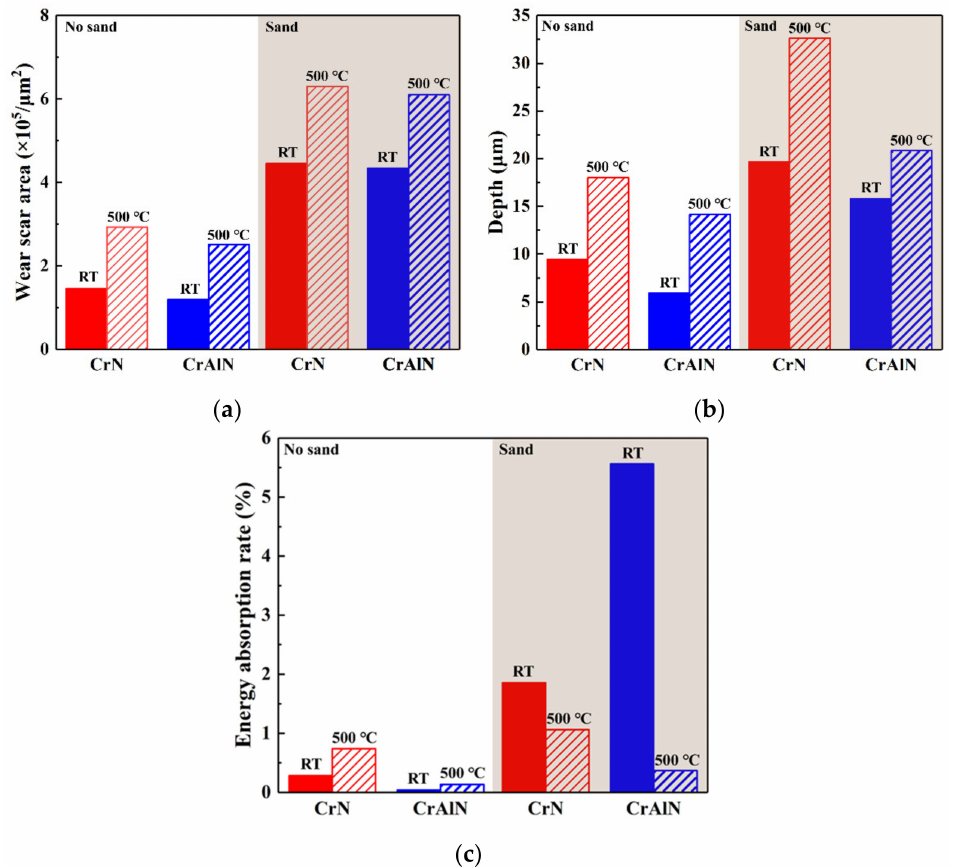
Figure 10. Area and depth of wear scar and total energy absorbed of the CrN and CrAlN coatings under RT and 500 ◦ C in and no-sand condition. ( a ) Wear scar area, ( b ) wear scar Depth, and ( c ) energy absorption rate of the CrN and CrAlN coatings at 10 4